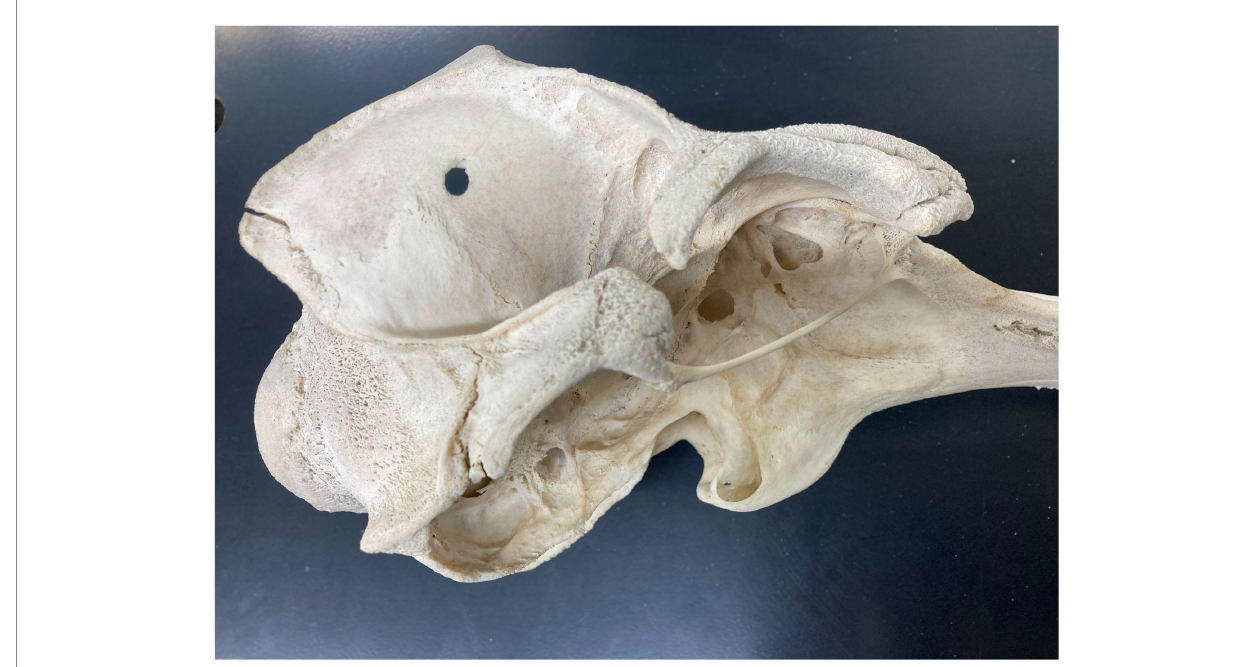
FIGURE 4 Temporal fossa, zygomatic arch, and pterygoid in Tursiops truncatus.